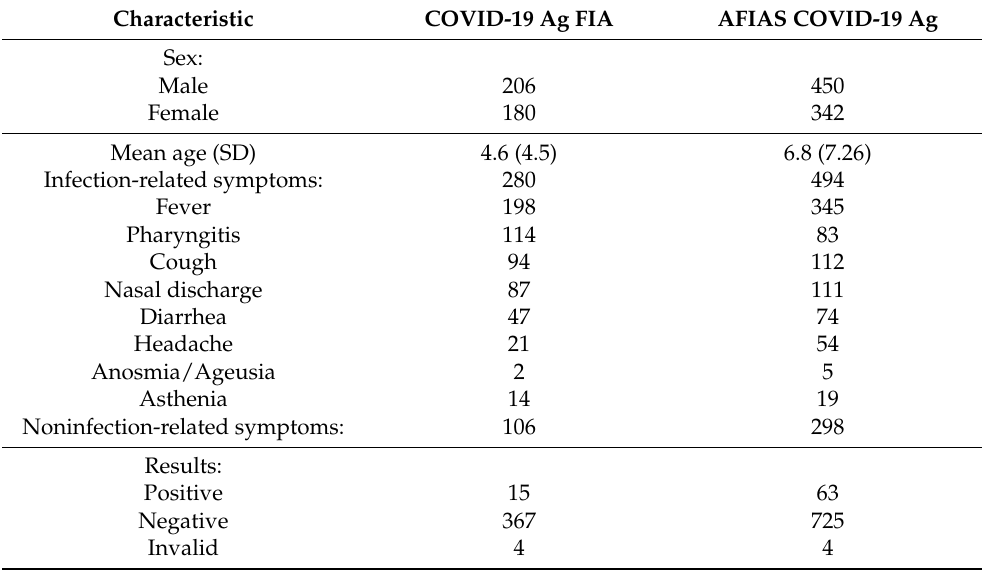
Table 1. Demographic and clinical characteristics of the population assessed in PED for the period of the study. SD = standard